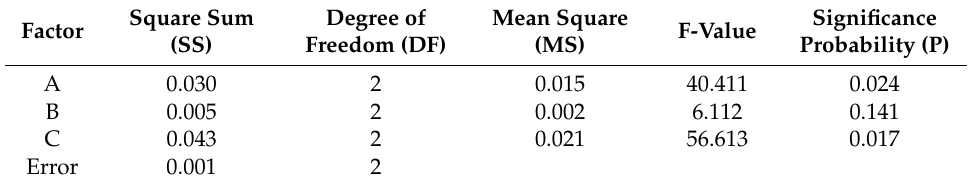
Table 7. Variance analysis of orthogonal